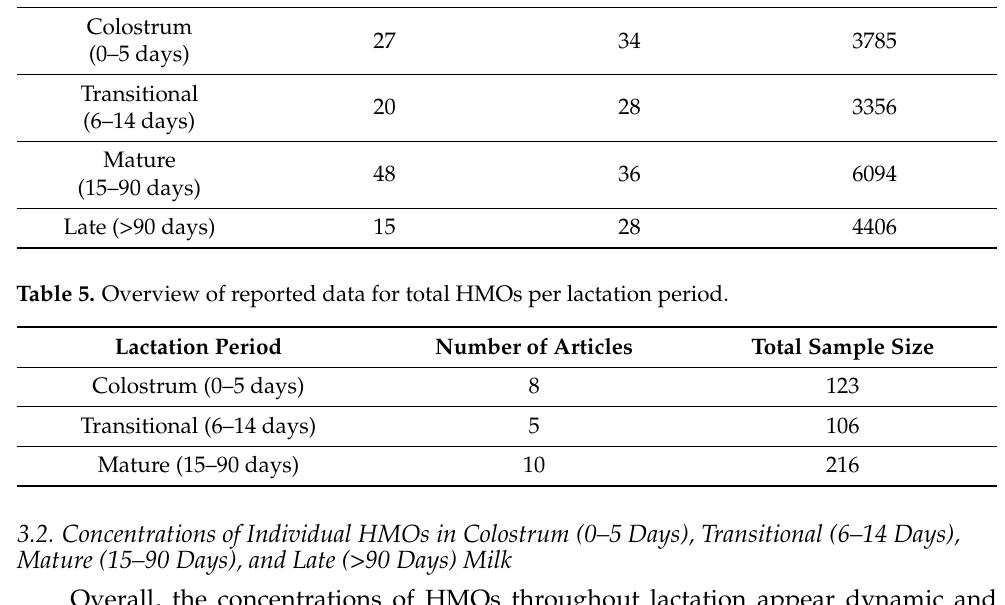
Number of Total Sample Size HMOs Quantified 3785